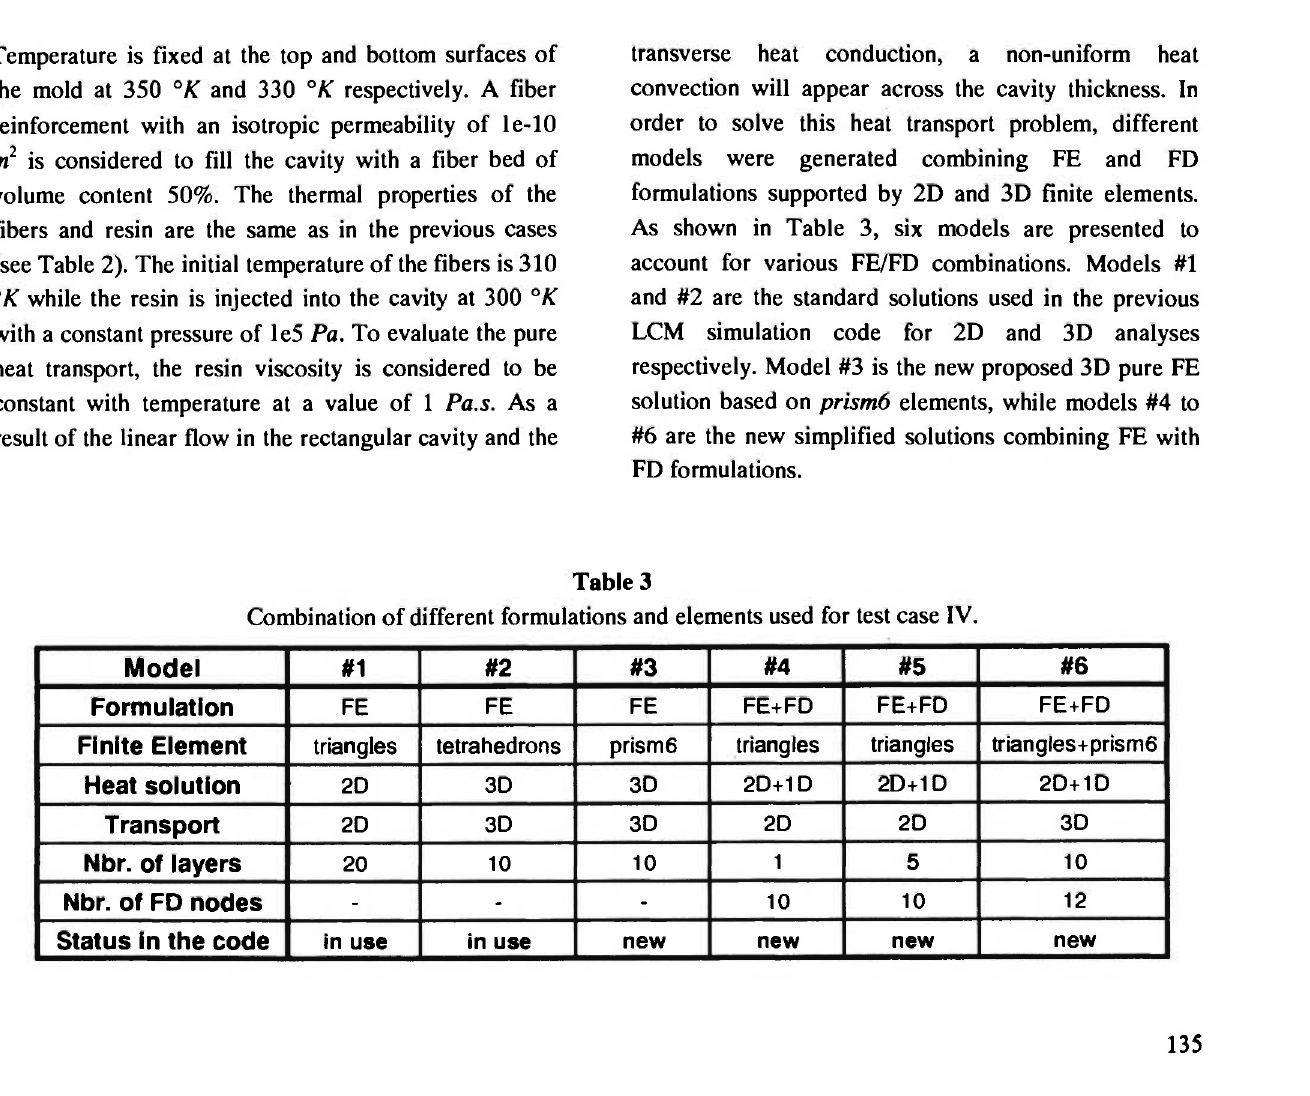
Temperature is fixed at the top and bottom surfaces of the mold at 350 °K and 330 °K respectively. A fiber